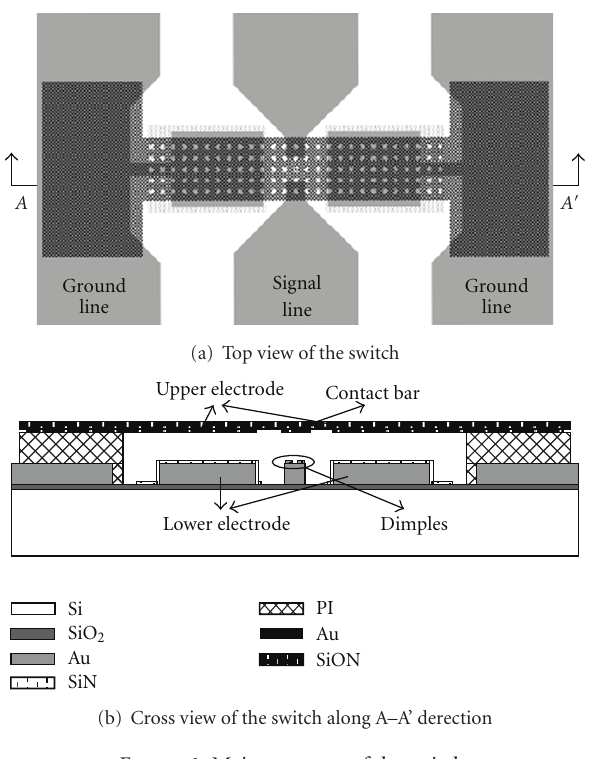
Figure 1: Main structure of the